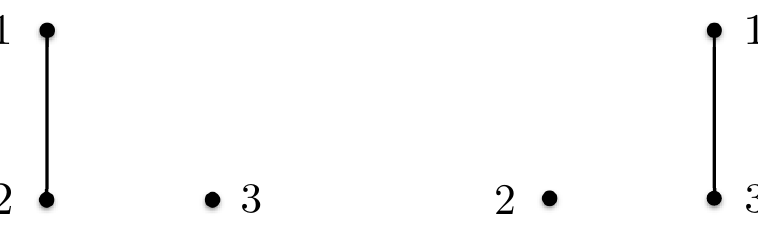
Figure 1: Trees associated with a minor of rank 2.